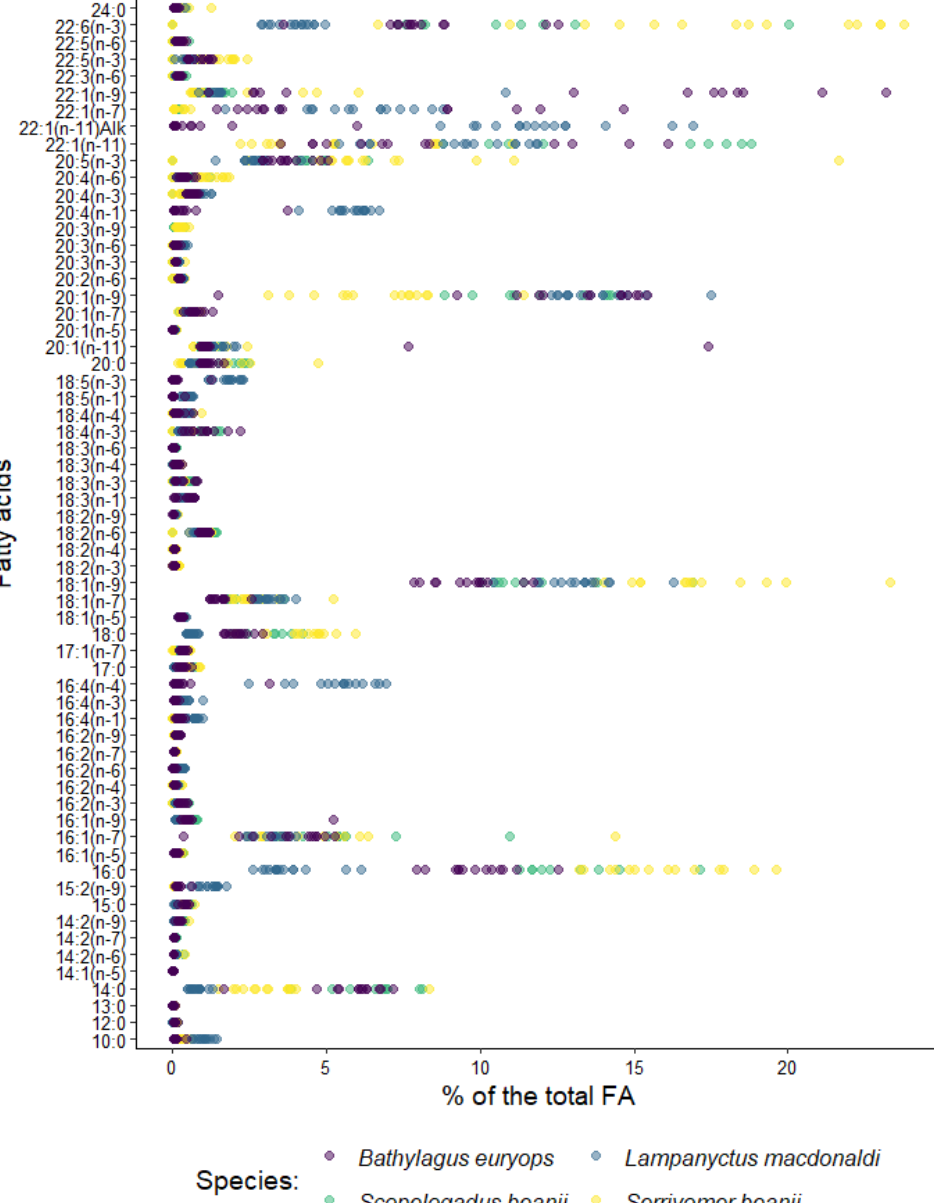
Figure 7. Fatty acids profile (% of the total FAs) of muscles of mesopelagic fish species ( Bathylagus euryops , Lampanyctus macdonaldi , Scopelogadus beanii , Serrivomer beanii ) living at different depths in the Irminger Sea (North Atlantic).